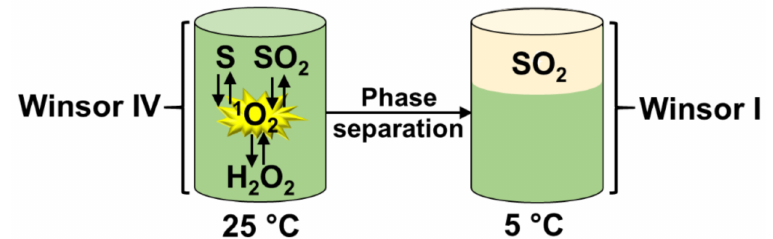
Figure 33. Interfacial catalytic oxidation in thermo-controlled and switchable microemulsions stabilized by bis(dimethyldioctylammonium) molybdate and tetraethylene glycol monooctyl ether (S: substrate, and SO 2 : oxidized